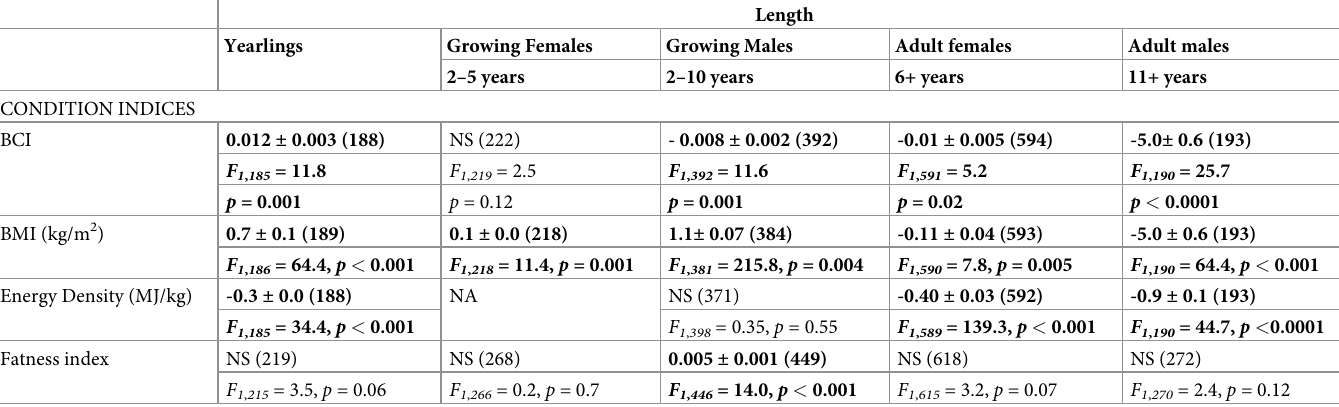
Table 4. Results of linear regression models examining whether condition indices are related to body length for polar bears in four sex/age